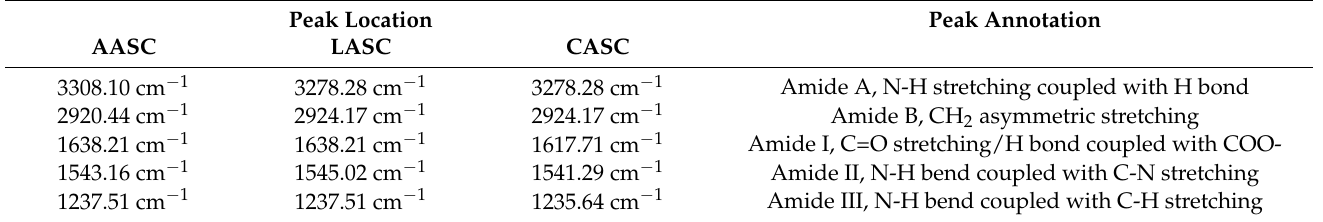
AASC: acetic acid soluble unicornfish ( N. reticulatus ) bone collagen; LASC: lactic acid soluble unicornfish bone collagen; CASC: citric acid soluble unicornfish bone collagen.